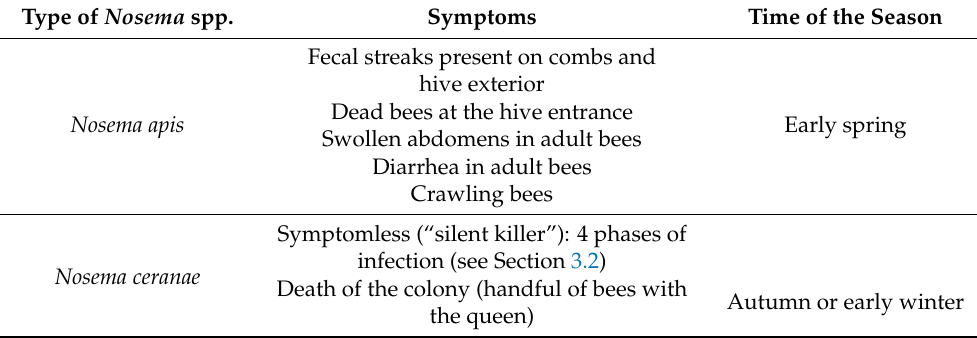
Table 1. Symptoms of both type of nosemosis which can be observed in the colony. Type of Nosema spp. Symptoms Time of the Season Fecal streaks present on combs and hive exterior springDead bees at the hive entrance Nosema apis Early Swollen abdomens in adult bees Diarrhea in adult bees Crawling bees Symptomless (“silent killer”): 4 phases of infection (see Section 3.2) Nosema ceranae Death of the colony (handful of bees with Autumn or early the queen)